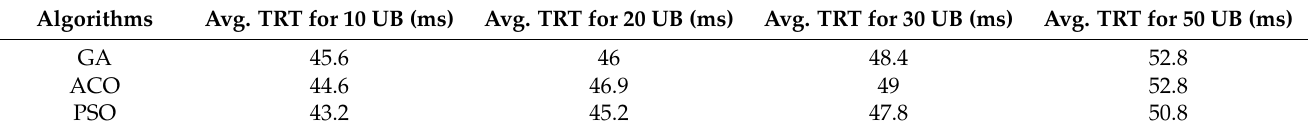
Table 8. Performance analysis of avg. TRT for 10, 20, 30, and 50 UB with 10 DC.